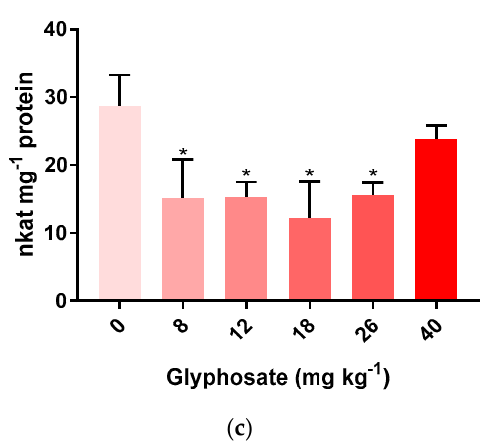
Figure 3. Average concentrations of carotenoid ( a ) and chlorophyll ( b ) and glutamine synthetase (GS) activity levels ( c ) in shoots of M. sativa plants 21 days after exposure to increased concentrations of GLY. Error bars correspond to the standard deviation. Statistically significant differences compared to the CTL, considering p ≤ 0.05, are marked with a * above bars.